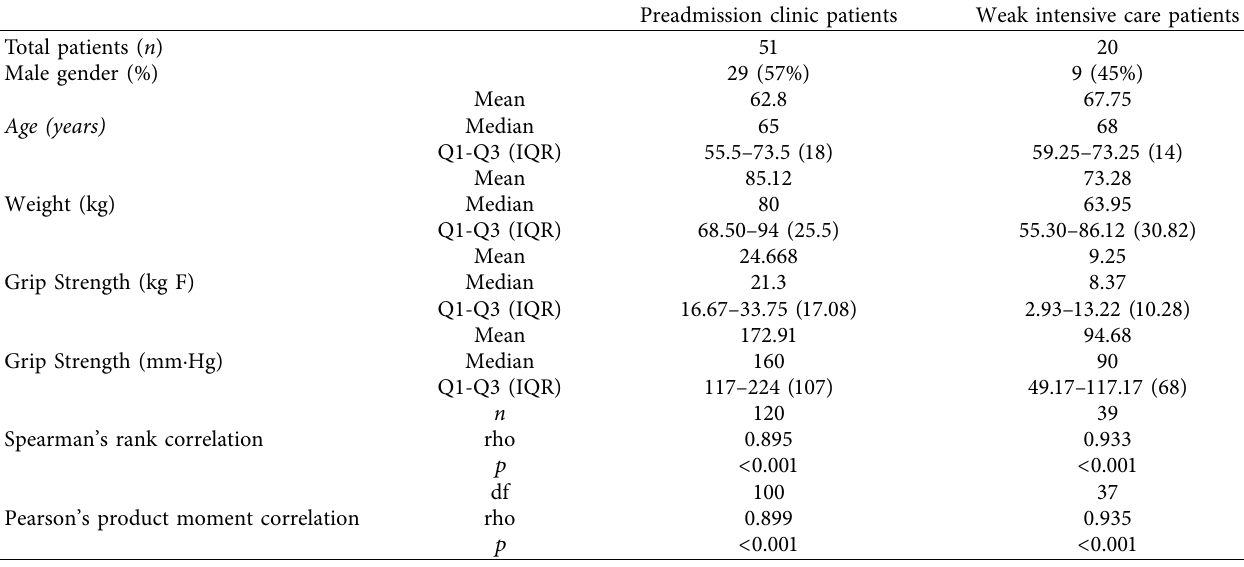
Table 1: Descriptive data for both cohorts.